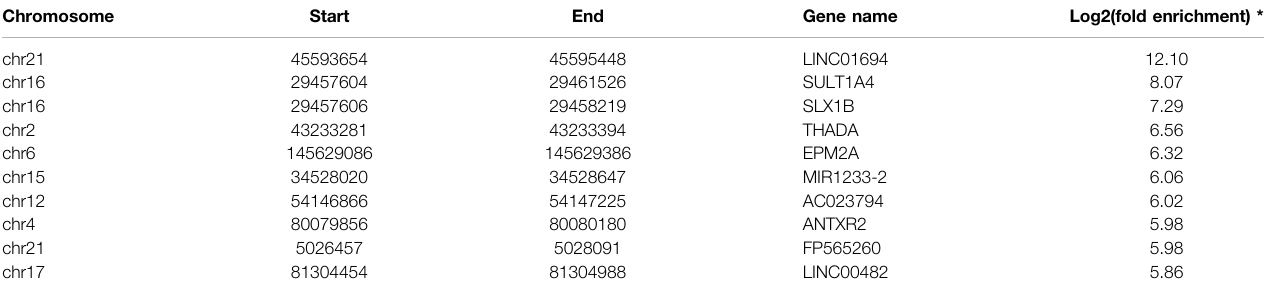
TABLE 2 | Top ten up-regulated methylated m 6 A-modi fi ed RNAs.